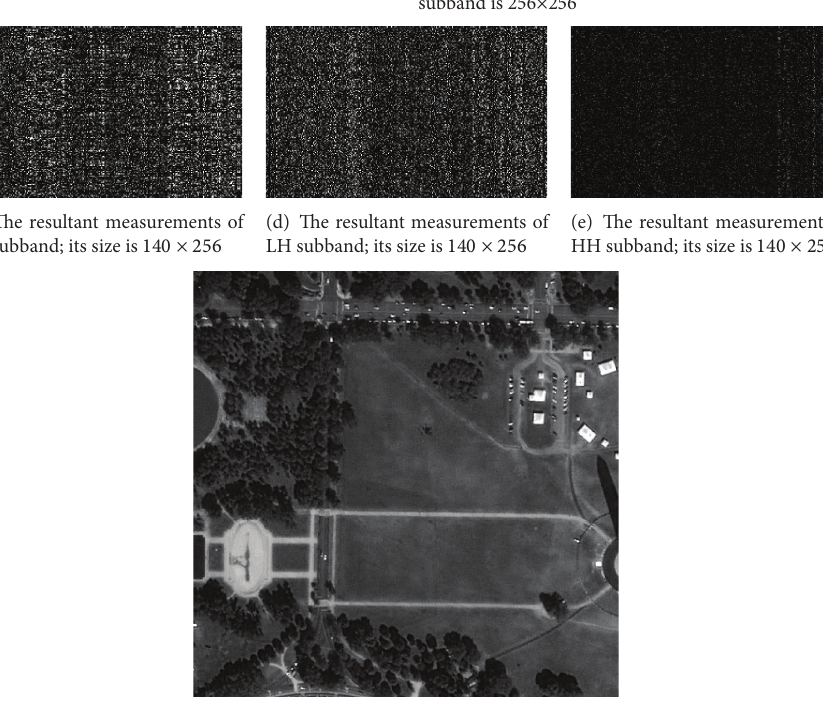
Figure 7: The compressive sensing process using DWT sparse representation for remote